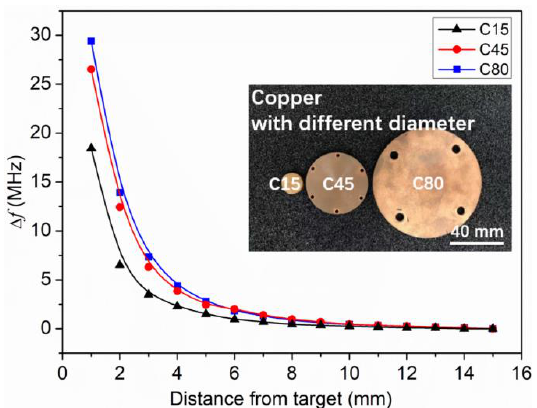
Figure 6. Frequency shift of the LC proximity sensor in dependence of the distance from the three targets of C15, C45, and C80. Sensors 2019 , 19 , x FOR PEER REVIEW